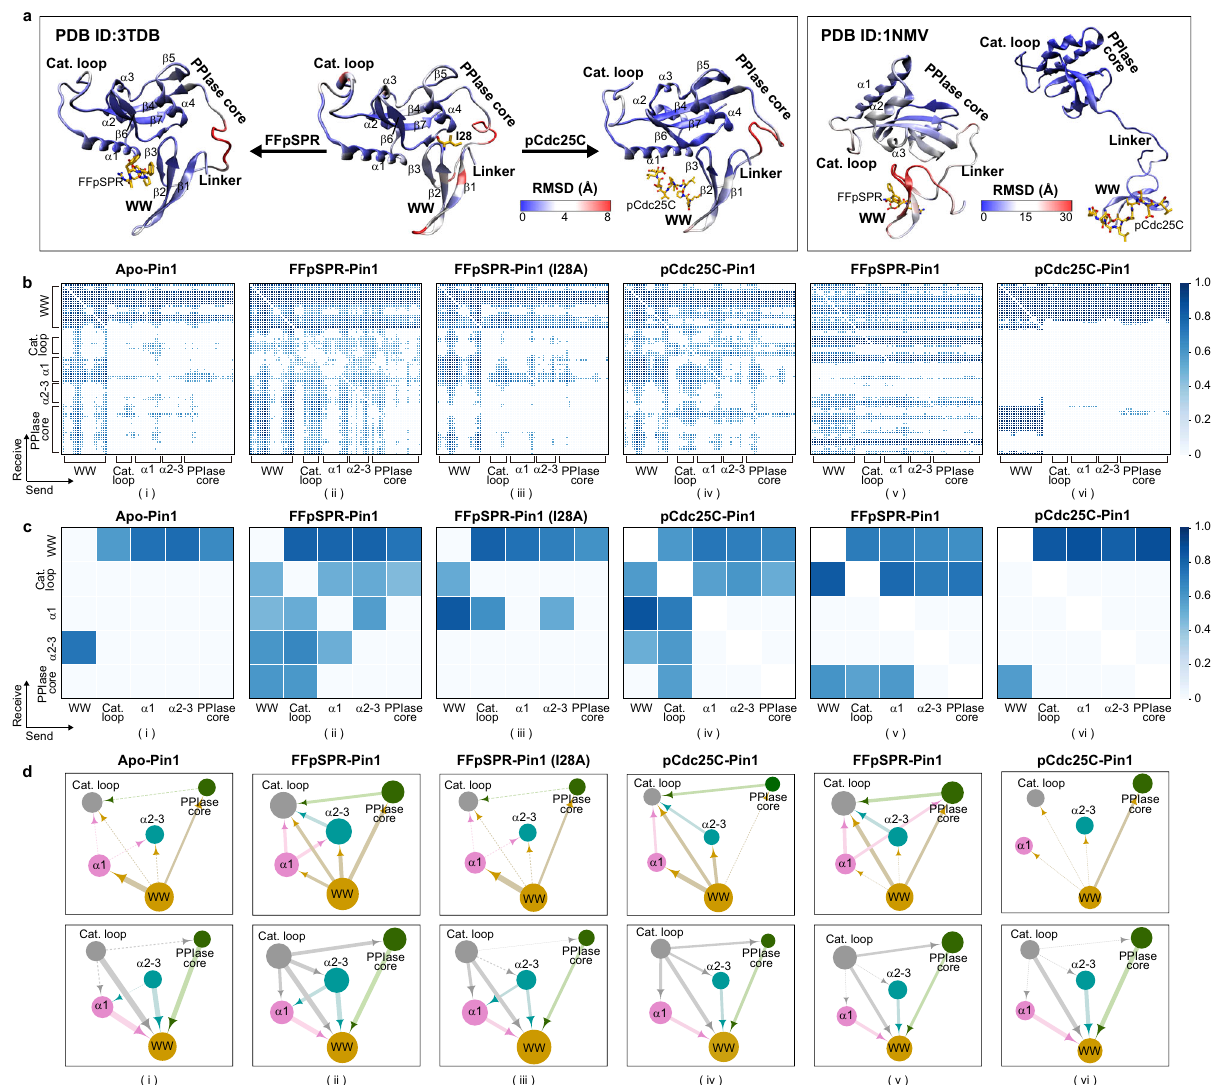
Fig. 2 Changes in protein fl exibility and interacting patterns upon ligand binding or mutation in Pin1. a Protein fl exibility of Pin1, where the color scale represents the backbone RMSD. b Distribution of learned edges between residues in the MD simulations of Pin1. c Distribution of learned edges between domains/blocks in the MD simulations of Pin1. d Interacting domains/blocks of Pin1, mapped from the learned edges. The Pin1 ensembles contain apo-Pin1 (PDB ID: 3TDB, i), FFpSPR-Pin1 (PDB ID: 3TDB, ii), FFpSPR-Pin1 (I28A) (PDB ID: 3TDB, iii), pCdc25C-Pin1 (PDB ID: 1PIN, iv), FFpSPR-Pin1 (PDB ID: 1NMV, v), and pCdc25C-Pin1 (PDB ID: 1NMV, vi) complexes. The size of a node represents the number of edges that directly connect to the node. The thickness of an edge represents the strength of the interaction. The arrows point to the directionality of a learned edge, i.e., the in fl uence from the one starting domain to the ending domain. The domains/blocks presented here are WW domain (WW), catalytic loop (Cat. loop), α 1-helix ( α 1), α 2-3 helices ( α 2-3), and PPIase